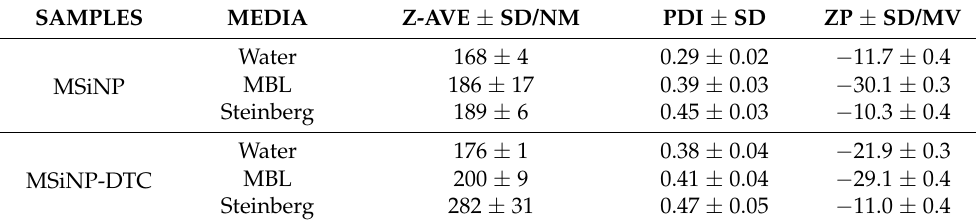
Table 1. Average hydrodynamic size ± standard deviation (Z-Ave ± SD), polydispersity index (PDI ± SD), and average zeta potential (ZP ± SD) recorded for MSiNPs and MSiNP-DTC dispersed at 200 mg L − 1 in water and in different assays’ culture